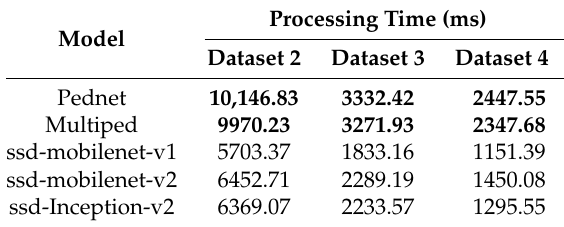
Table 3. Average processing time on embedded board